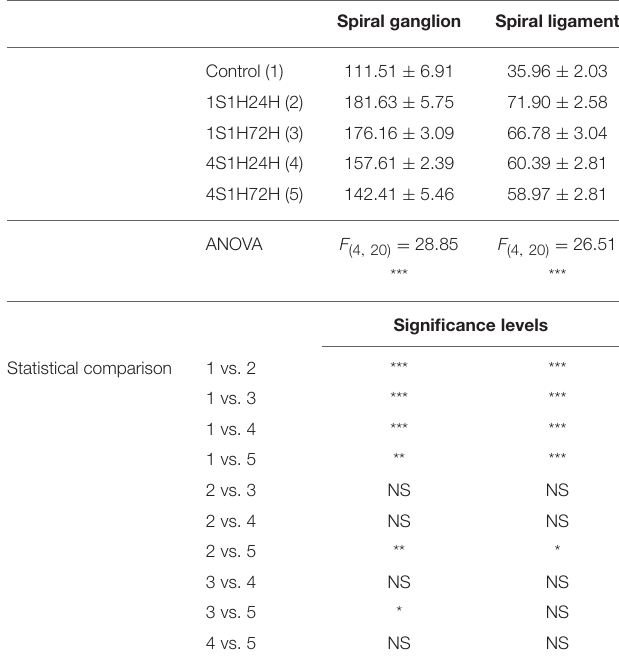
TABLE 6 | Mean gray level of NOS immunostaining in the spiral ganglion and Spiral ligament in control and experimental animals.